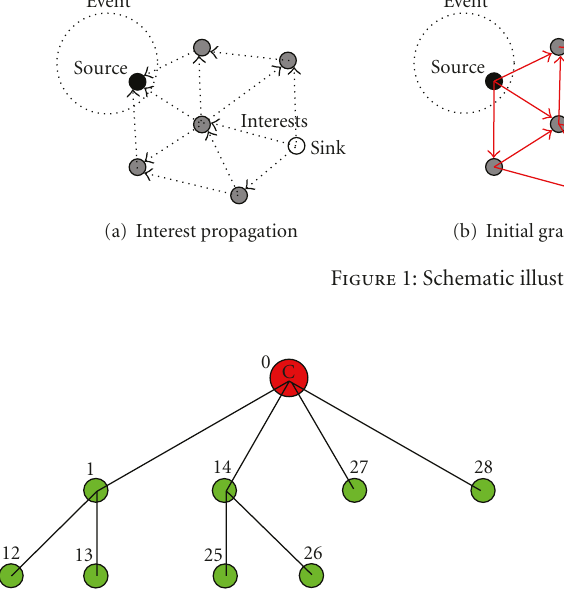
Figure 2: An example ZigBee network built by C skip algorithm, where Cm = 4, Rm = 4, and Lm = 3.